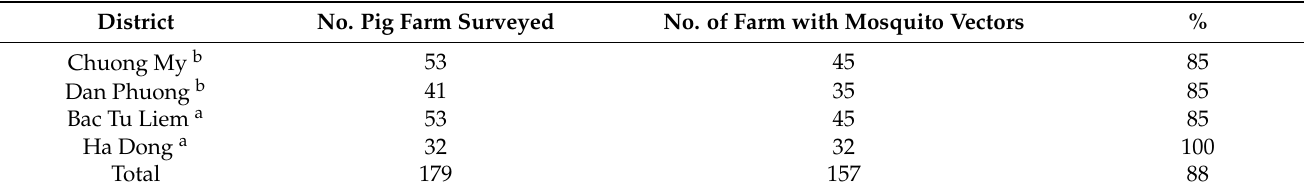
Table 5. Summary of mosquito vector